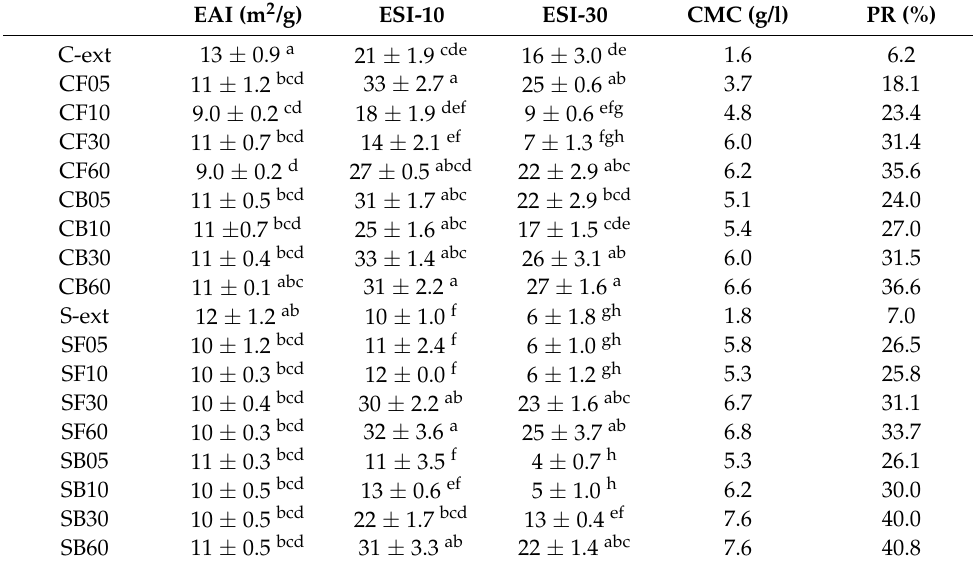
Table 3. Measured emulsion activity index (EAI *) and stability index after 10 and 30 min (ESI- 10/30 *), critical micelle concentration (CMC **) and protein recovery (PR) of hydrolysates and direct protein extracts (-ext) based on cod (C) and salmon (S) backbones with FoodPro PNL (F) and Bromelain (B) for 5, 10, 30 and 60 min of